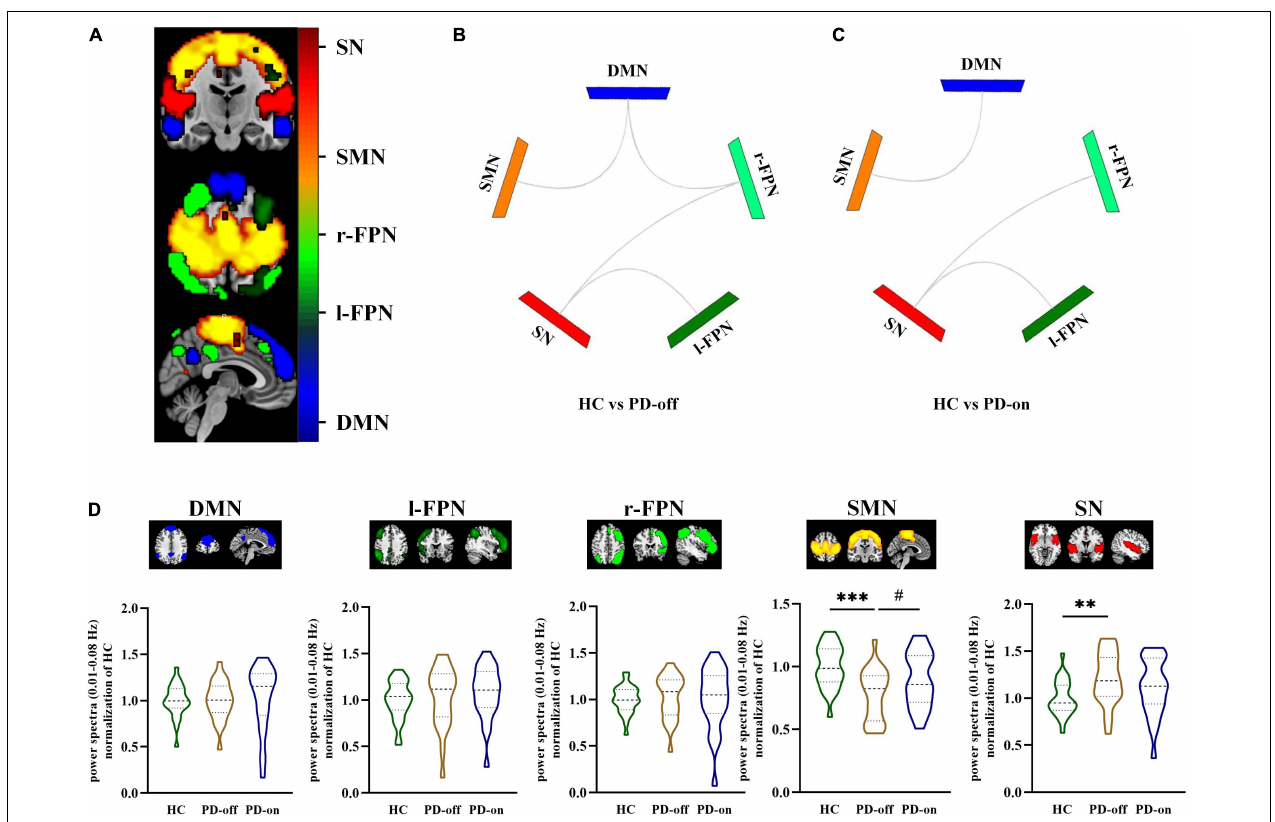
FIGURE 2 | Selected resting-state networks (RSNs) and comparisons between groups in network level. (A) Selected RSNs (e.g., HC group): DMN, l-FPN, r-FPN, SMN, and SN (distinguished by colors, a one-sample t -test was used, and the threshold of the display was set to the cluster-level false discovery rate (FDR)-corrected P < 0.05). Different functional connectivities of selected networks were compared between (B) HC and PD-off and (C) HC and PD-on (significant differences were shown in gray line); no significant differences were seen between PD-off and PD-on. (D) Power spectra (0.01–0.08 Hz) differences between HC, PD-off, and PD-on within each network. Data are represented as the median (Q1, Q3). ∗ , # P < 0.05; ∗∗ P < 0.01; ∗∗∗ P < 0.001 ( ∗ compared with controls, # compared with PD-off). HC, healthy control; PD, Parkinson’s disease; SMN, sensorimotor networks; DMN, default mode network; FPN, frontoparietal network; SN, salience